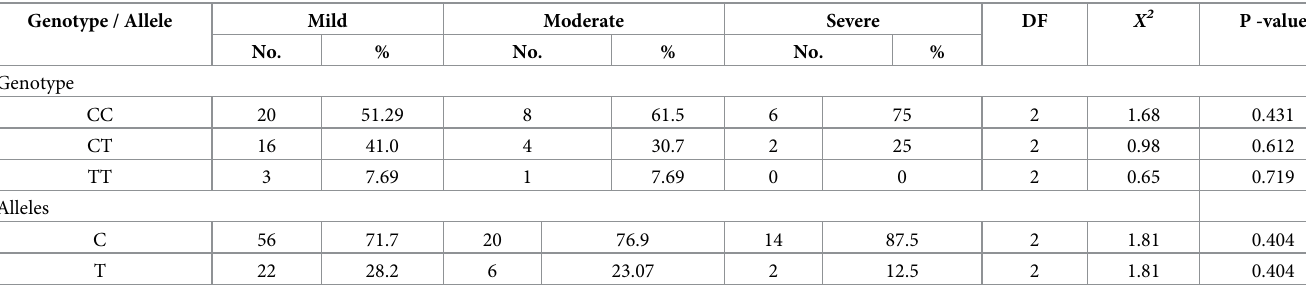
Table 6. OXTR polymorphism rs2268491 in ASD severity categories.